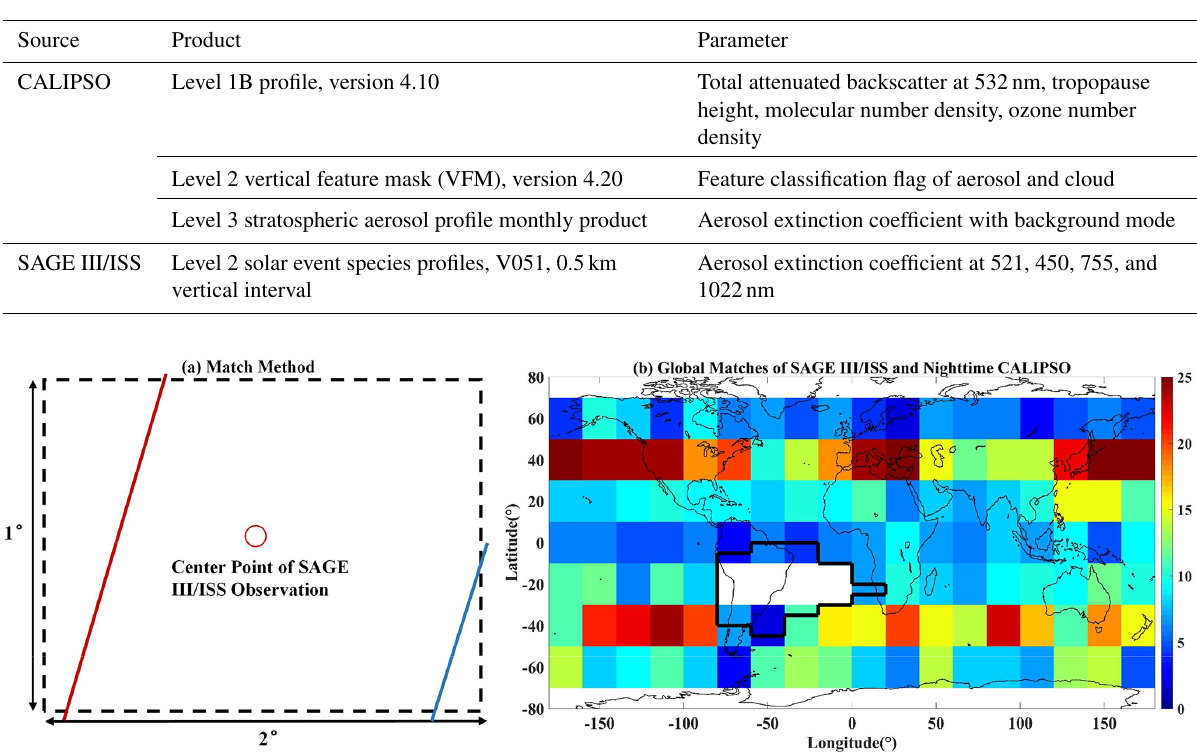
Figure 1. (a) Schematic of the CALIPSO match to the SAGE III/ISS. The red circle represents the centre point of SAGE III/ISS observations. The red and blue lines represent cases of successful and failed (CALIPSO track is less than 0.75 ◦ in the grid) matched cases, respectively. (b) The number of globally matched CALIPSO and SAGE III/ISS observations during night-time from June 2017 to May 2020. The black boundary represents the South Atlantic Anomaly (SAA), where CALIPSO experiences an elevated frequency of low-energy laser shots. The colour bar represents the number of matched cases in each 20 ◦ × 20 ◦